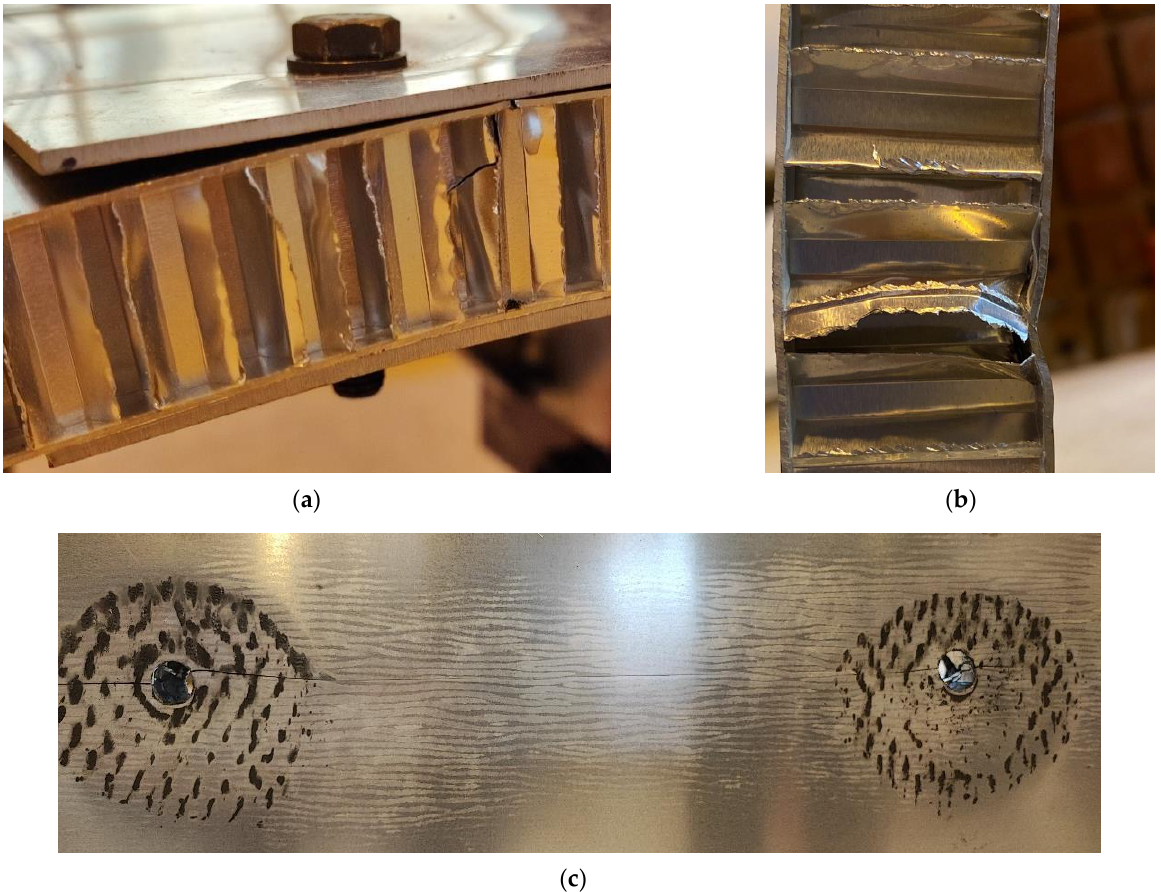
Figure 13. Failed honeycomb panel after the fatigue test at variable amplitude displacements: ( a ) shear crack on a later cell wall; ( b ) collapsed cell after local buckling; ( c ) crack between holes for bolts.